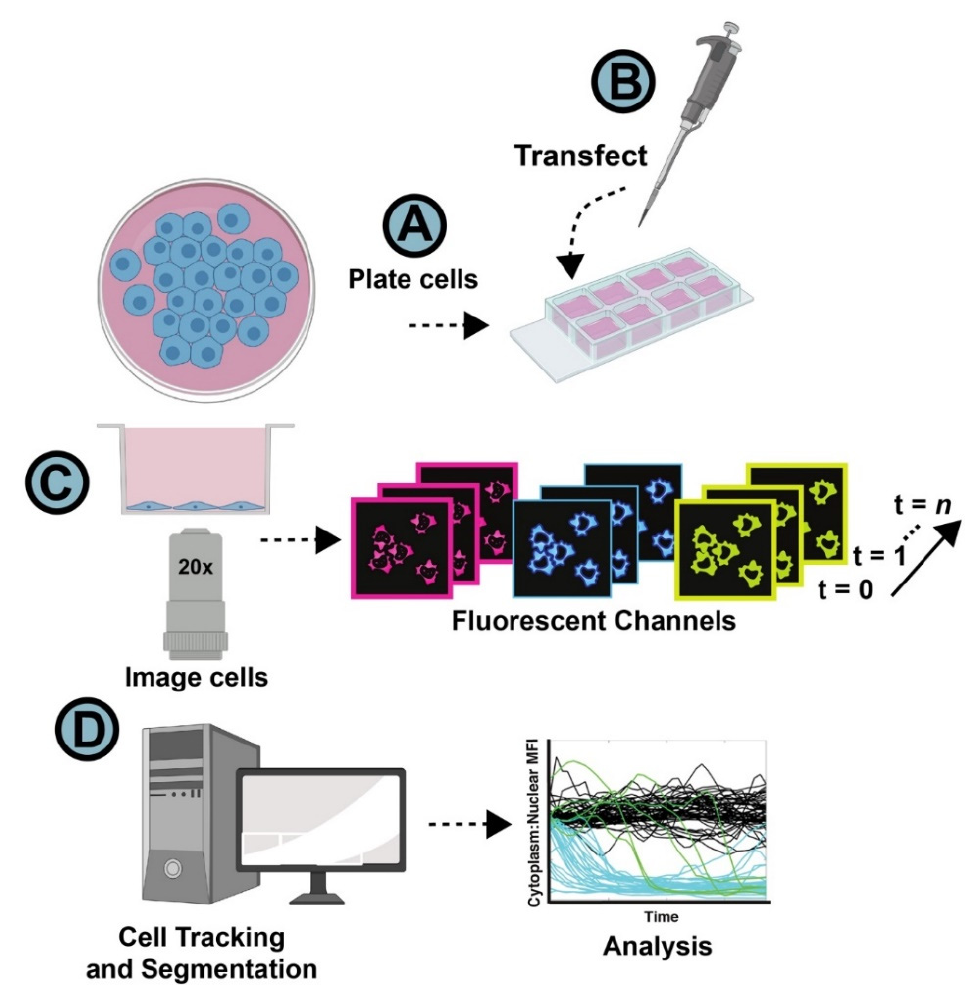
Figure 2. General image acquisition and analysis workflow. ( A ) Adherent cells were plated in 8-well glass-bottomed dishes and allowed to settle for 24 h. ( B ) Cells were transfected to express visible US vRNAs and Rev-mCherry. ( C ) Cells were imaged using multipoint acquisition (3 points per well) 4–6 h post-transfection using a 20 × objective, capturing > 100 transfected cells per condition. Images were acquired for each channel over a prescribed time course. ( D ) Images were post-processed for NR-SAT and analysis using KNIME, with data output to graphing software.